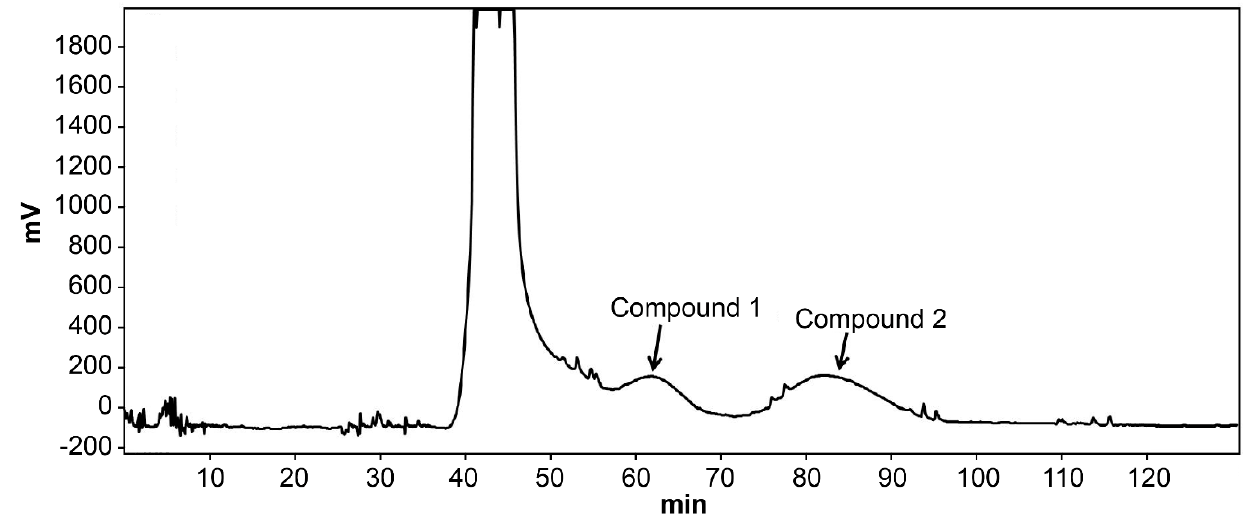
Figure 5. High-speed countercurrent chromatography separation of the crude extract of Inonotus obliquus . n -hexane-ethyl acetate-MeOH-water (5:5:3:7, v / v / v / v ); flow rate: 1.5 mL/min; detection wavelength: 300 nm; rotational speed: 850 rpm; sample size: 100 mg.